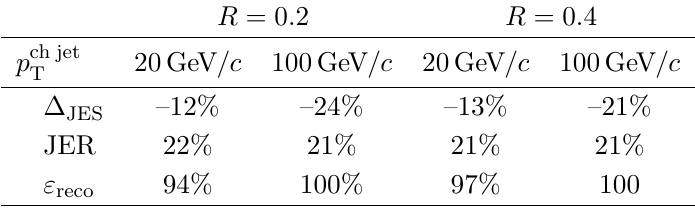
Table 1 . Approximate values characterizing the jet reconstruction performance for R = 0 . 2 and 0 . 4 in pp collisions. ∆ JES is the mean jet energy scale shift, JER is the jet energy resolution, and (cid:15) reco is the reconstruction